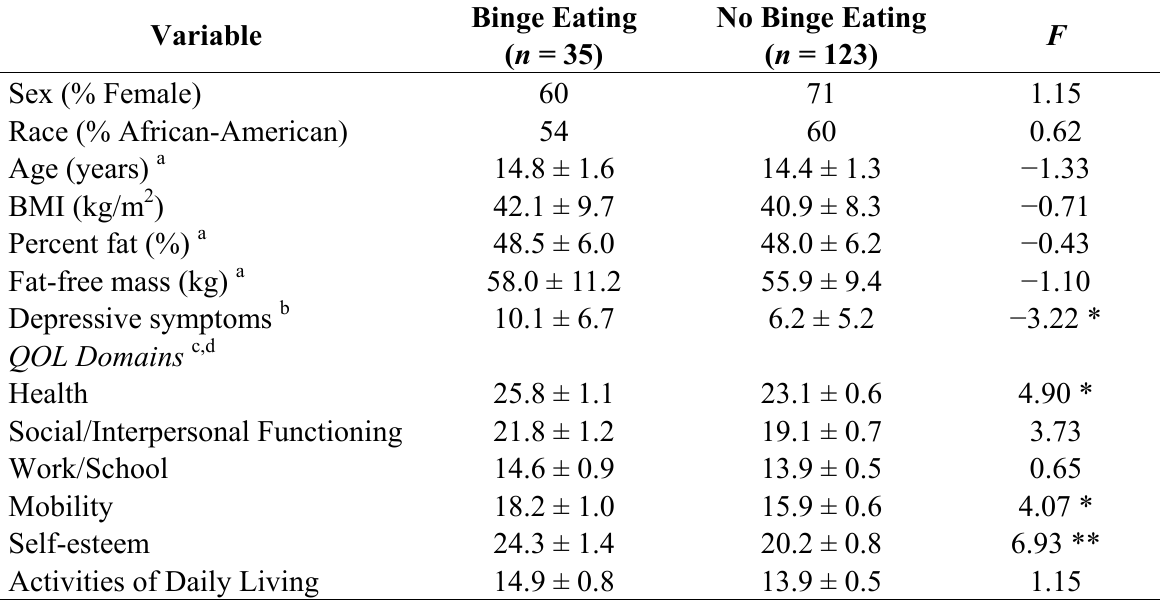
Table 1. Demographic, Anthropometric, and Psychological Variables of Study Sample by Binge Eating